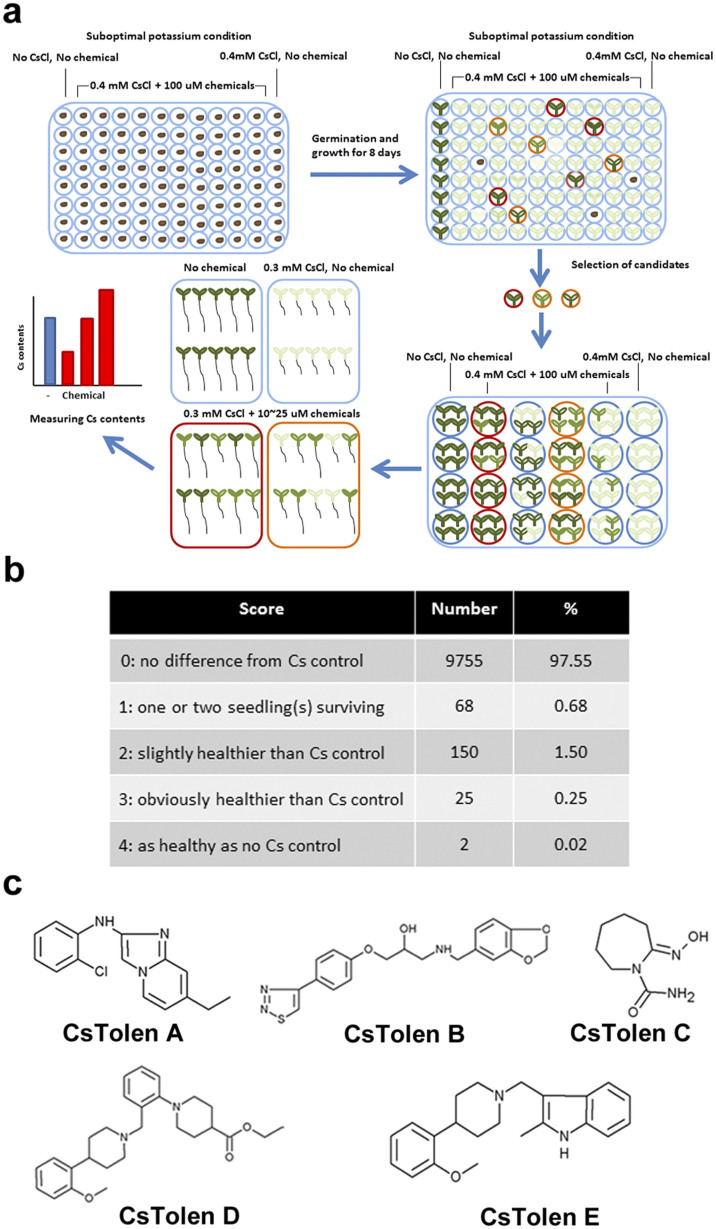
Chemical library screening.(a) Schematic representation of chemical screening. Wild type (Col-0) seeds were sown on 0.5 mM KCl + 0.4 mM CsCl media containing 100 μM chemical and grown for 8 days prior to scoring. Those chemicals which rendered plants tolerant to Cs+ were chosen as candidates. Further screenings were performed on a larger scale. Cs+ concentrations in the seedlings were determined at the final screening. (b) Scoring results of the initial screening. Number and the percentage of chemicals which fall into each score are shown. (c) Chemical structures of Cs+ tolerance enhancers (CsTolen A–E). The candidate chemicals with score >1 were selected and analysed through four steps of screenings. Consequently, five chemicals were confirmed to enhance plant tolerance to Cs+.